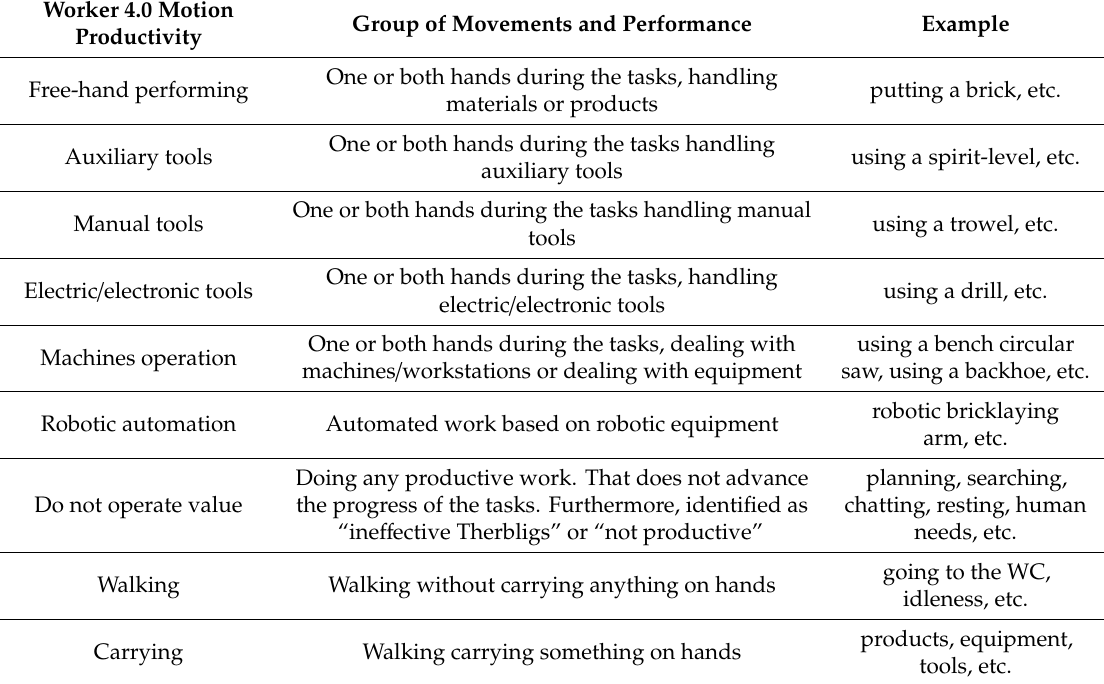
Table 3. Worker 4.0: motion productivity